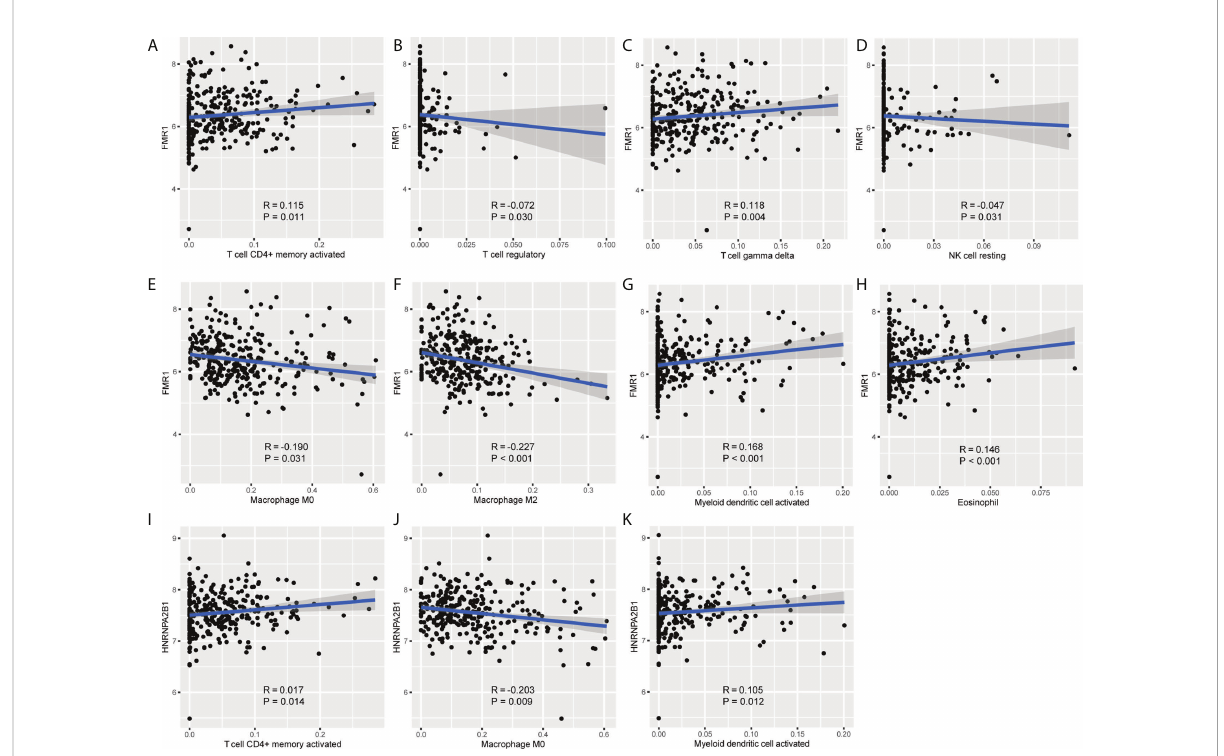
FIGURE 4 The relationship of FMR1 and HNRNPA2B1 with different types of immune cells. (A – H) Correlation plots show the relationship between FMR1 and different types of immunocytes. (I – K) Correlation plots show the relationship between HNRNPA2B1 and different types of immunocytes.